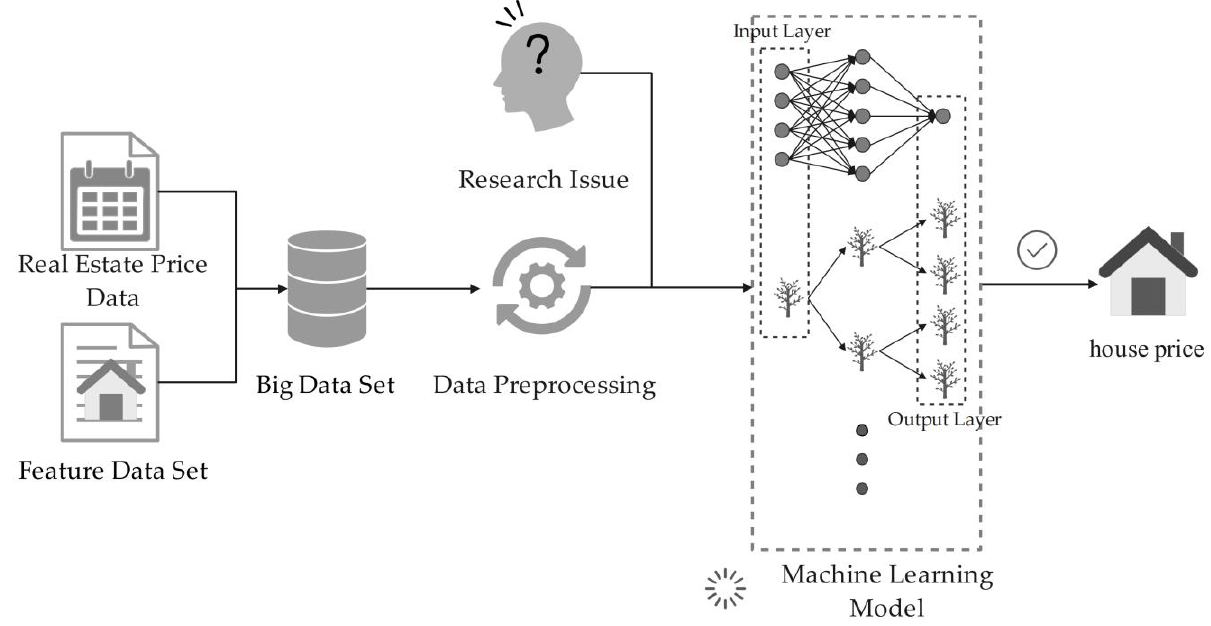
Figure 4. Flow chart of applying machine learning to real estate appraisal.